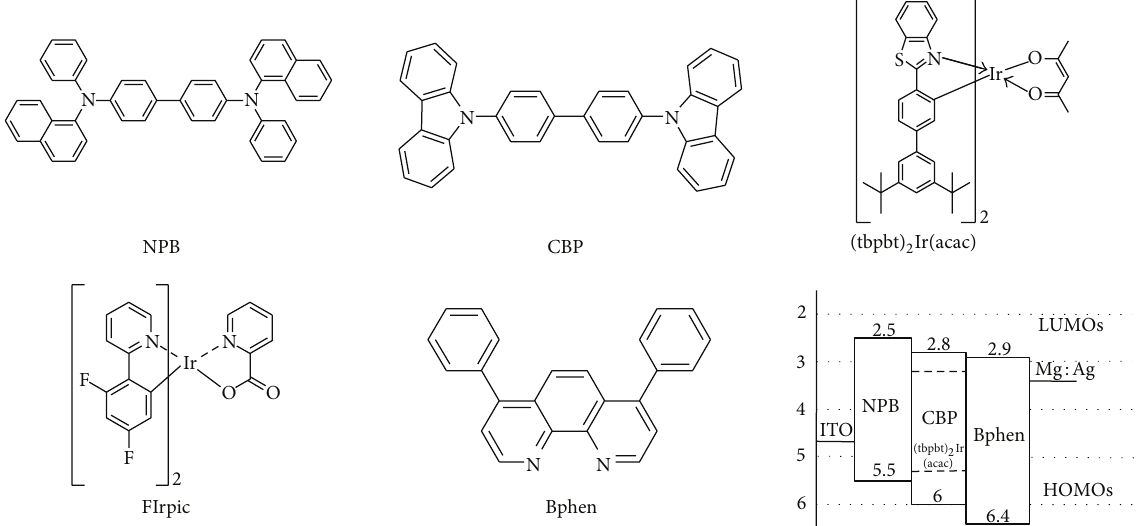
Figure 1: Molecular structures of organic materials and energy level diagram of orange OLEDs in this